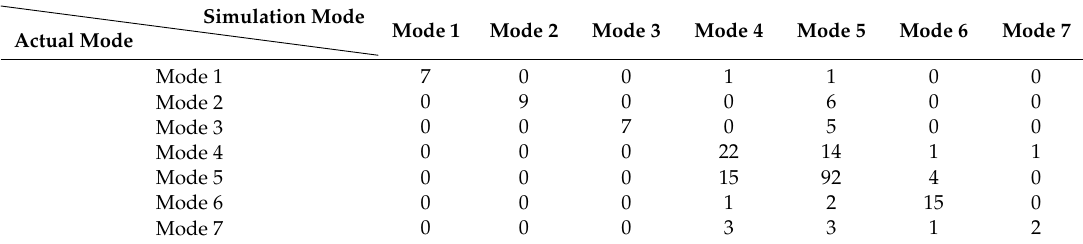
Table 2. The confusion matrix of the taxi mobility pattern classification